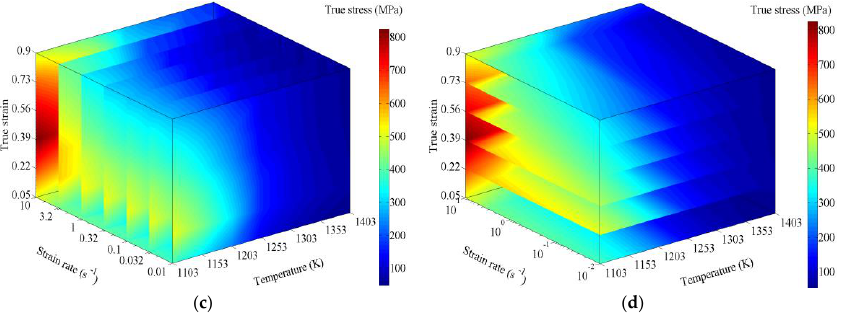
Figure 10. The continuous mapping relationship among temperature, strain rate, strain and stress ( a ) in a global version as well as under fixed ( b ) temperatures; ( c ) strain rates and ( d ) strains. The continuous mapping relationship plays an essential part in finite element method (FEM).